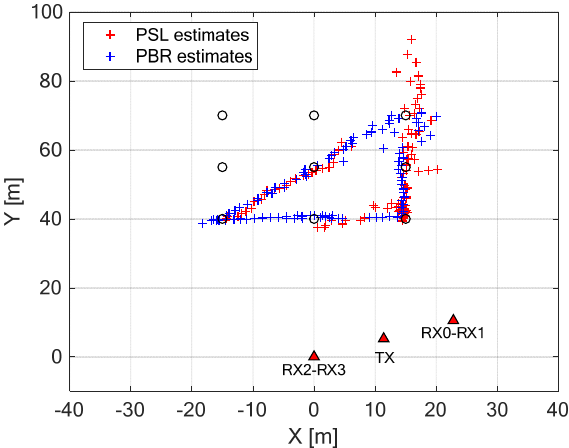
Figure 12. Comparison of the PSL and the PBR localizations on the x-y plane.